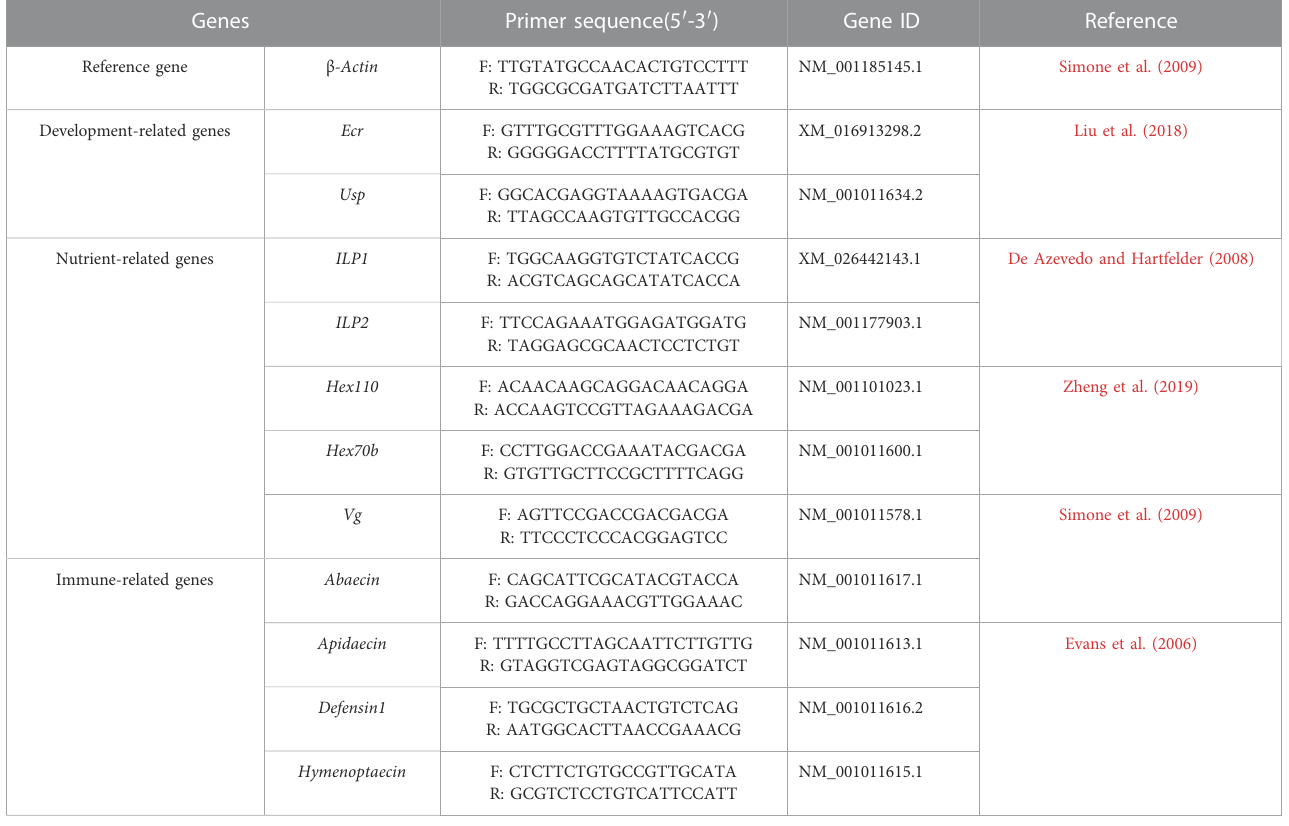
TABLE 1 Primers of development-, nutrient- and immune-related genes used for quantitative PCR. Genes